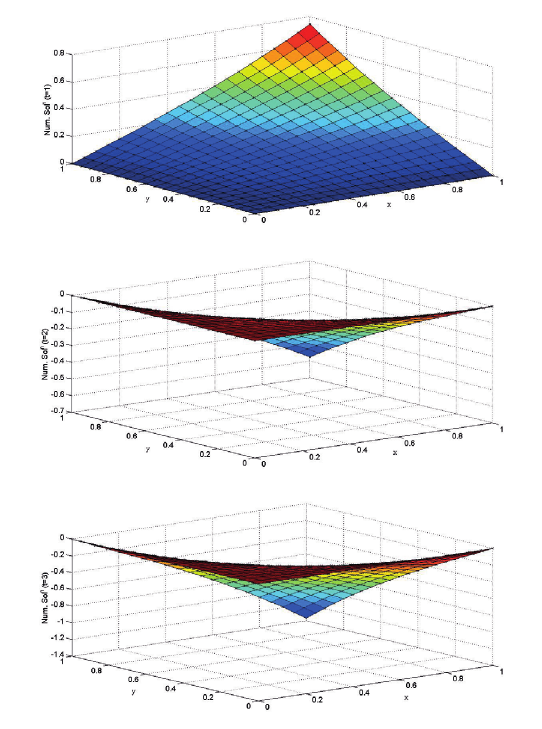
Fig. 4: Plots of mExp-DQM solution solution of Example 5.3 Fig. 5: Plots of numerical solution at different time levels for Exam- ple 5.4